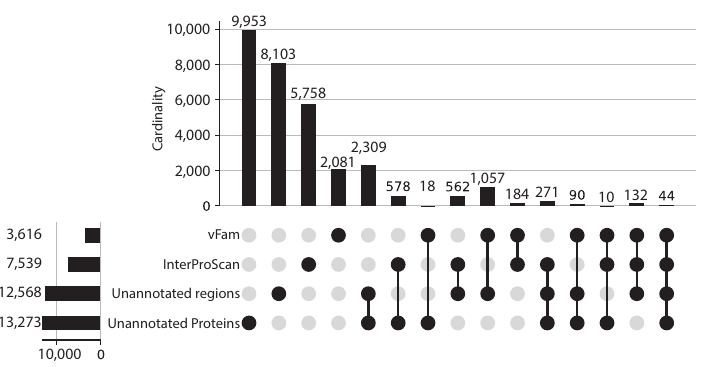
Figure 3. ViPhOGs composition: Most of the orthologous regions are made of unknown regions. Plot showing the ViPhOGs composition according to the type of region it has (vFam, InterProScan, unannotated region, unannotated protein). The horizontal bar plot represents the number of ViPhOGs that possess at least one region of the indicated type. Filled dots indicate which combination of types is being considered and the vertical bar plot shows the number of ViPhOGs for each